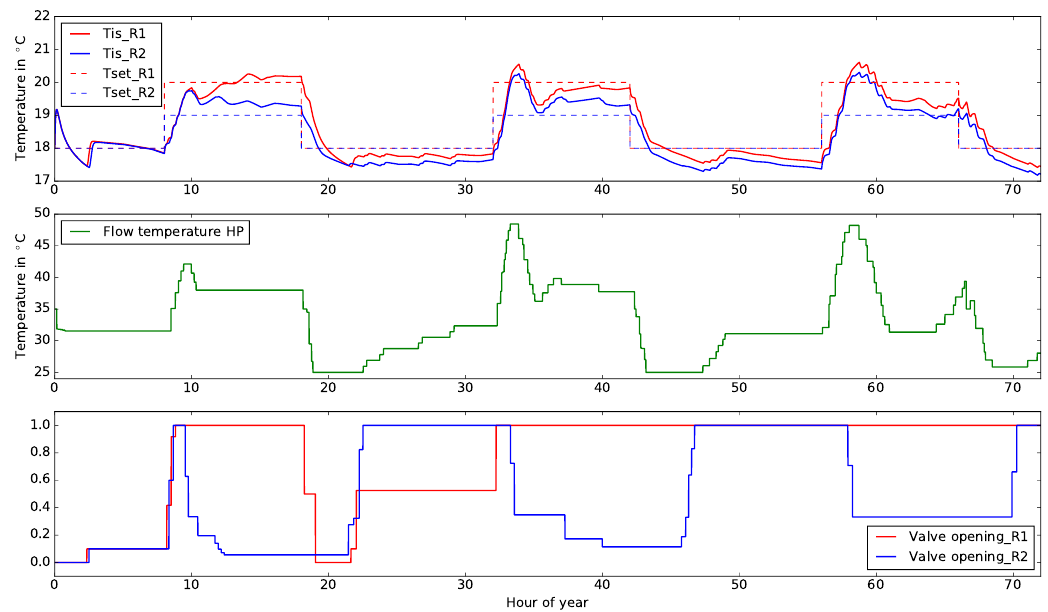
Figure 8. Air temperature, flow temperature to the room and valve opening for room 1 (R1) and room 2 (R2) in a heating